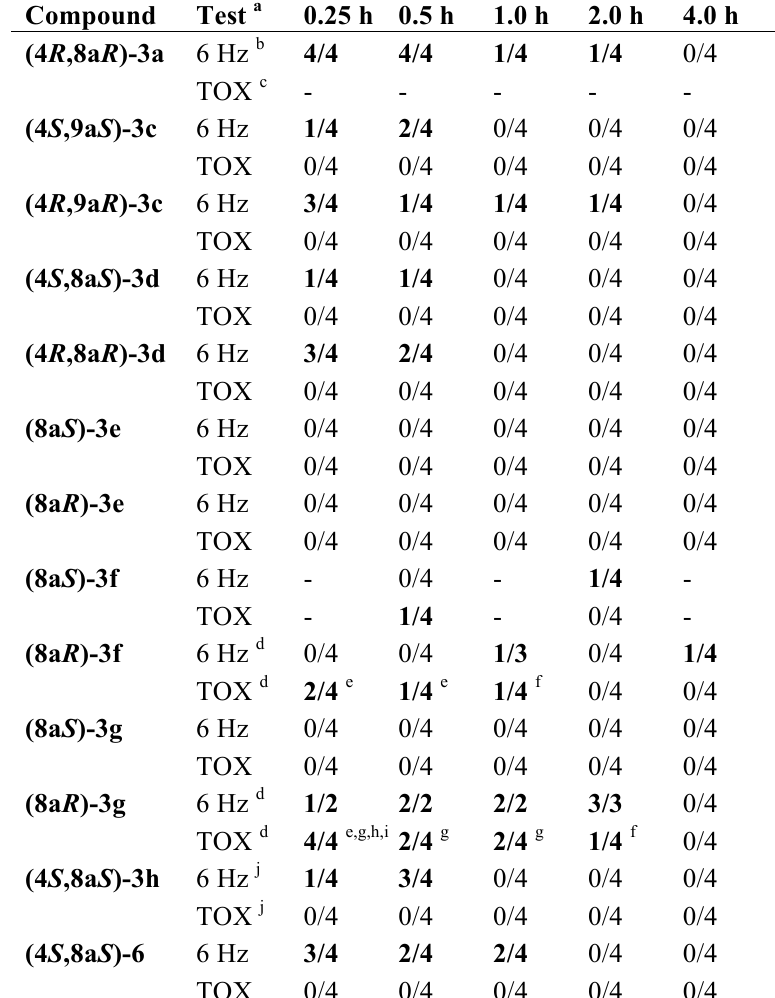
Table 3. Anticonvulsant activity and neurotoxicity of compounds in the 6 Hz model following intraperitoneal (ip.) administration in